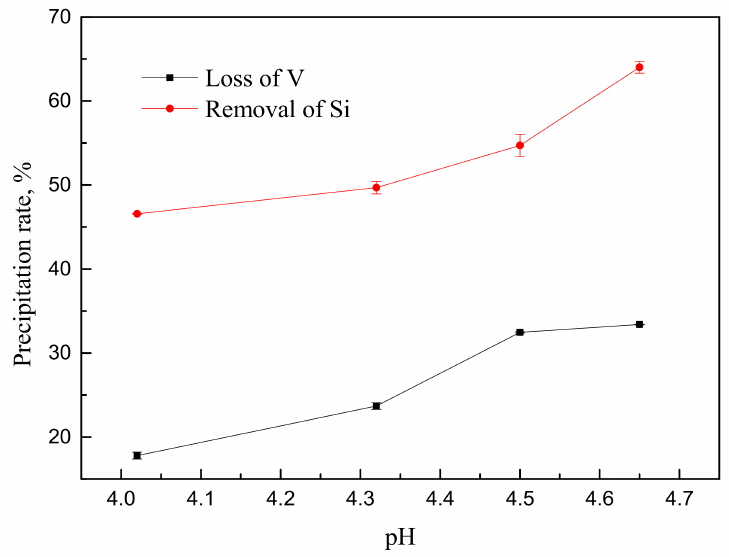
Figure 2. Effect of pH value on the removal of silicon and the loss of vanadium at 65 ◦ C. Table 3. Effect of pH value on the removal of silicon and the loss of vanadium at 80 ◦ C. Precipitation Rate, %